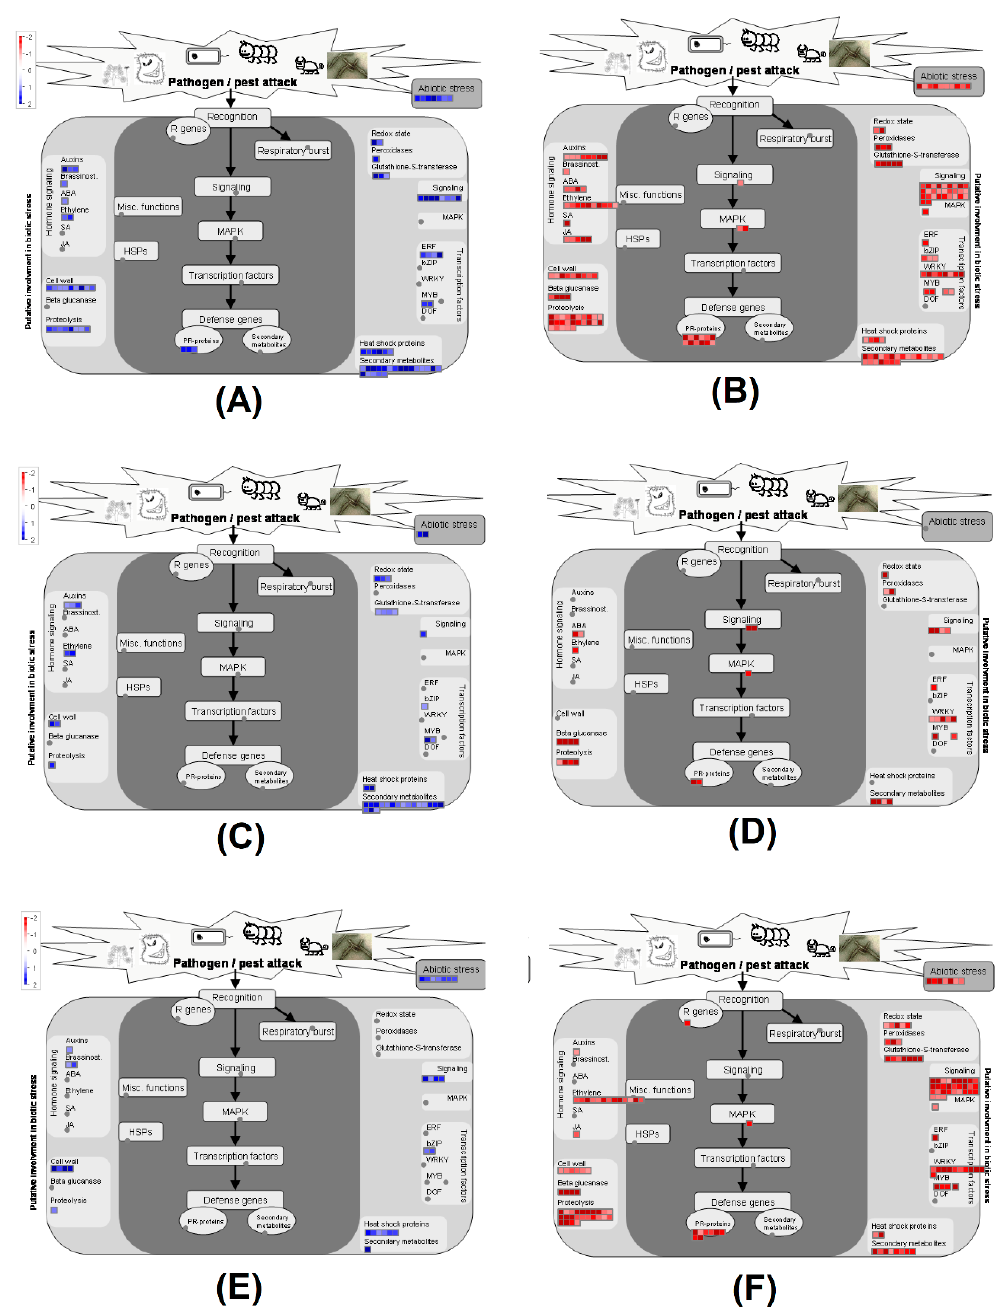
Figure 5. BS inoculation-induced DEGs in the biotic pathway for di ff erent tomato lines. Illustration of ( A ) PI 270443 upregulated DEGs (blue color) ( B ) PI 270443 downregulated DEGs (red color). ( C ) NC 1CELBR upregulated DEGs (blue color) ( D ) NC 1CELBR downregulated DEGs (red color). ( E ) NC 714 upregulated DEGs (blue color) ( F ) NC 714 downregulated DEGs (red color) in the biotic stress pathway via MapMan.